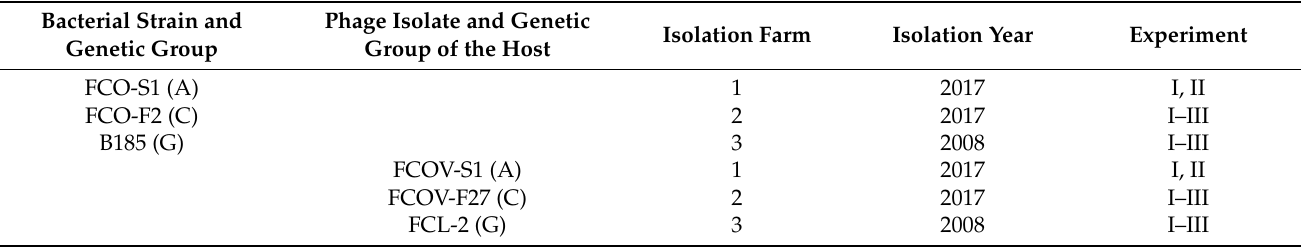
Table 1. Flavobacterium columnare and their phages used in this study. Bacteria and phages were isolated from Finnish and Swedish fish farms. F. columnare isolates have been previously categorised into genetic groups by restriction fragment length polymorphism analysis of the internal transcribed spacer region between 16S and 23S rRNA